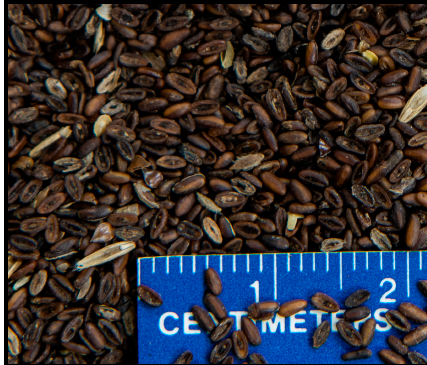
Figure 1. Seed utilized in germination testing on the thermogradient table and greenhouse experiments. Seed size of Plantago lanceolata L. from Webster County Georgia, USA (photograph by Sidney Cromer, used with permission).